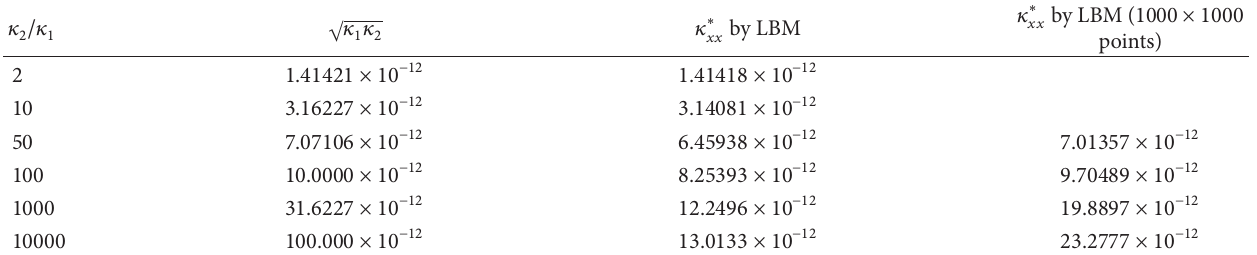
Table 3: Verification of computed 𝜅 ∗ 𝑥𝑥 , 𝜅 1 = 10 −12 m 2 and ] eff = 0 m 2 s −1